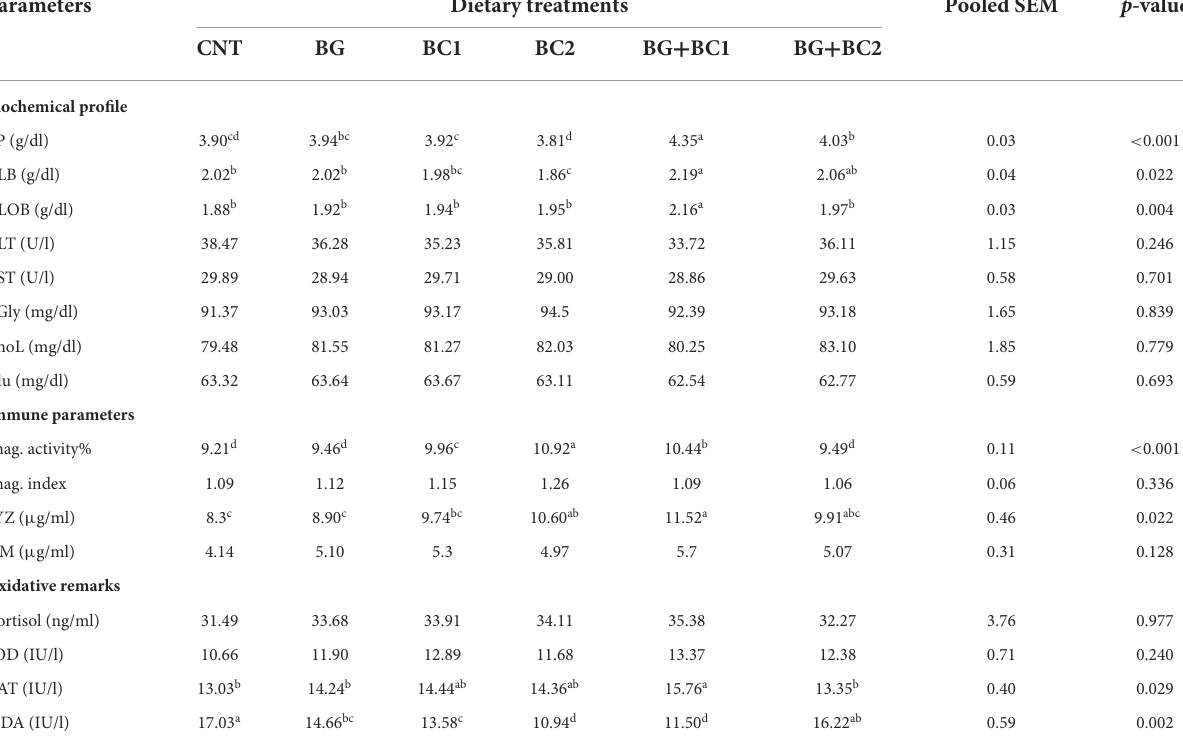
TABLE 6 Effects of dietary supplementation with β -glucan and/or Bacillus coagulans on blood biochemical profile, oxidative remarks and immune activity of tilapia fish. Parameters Dietary treatments Pooled